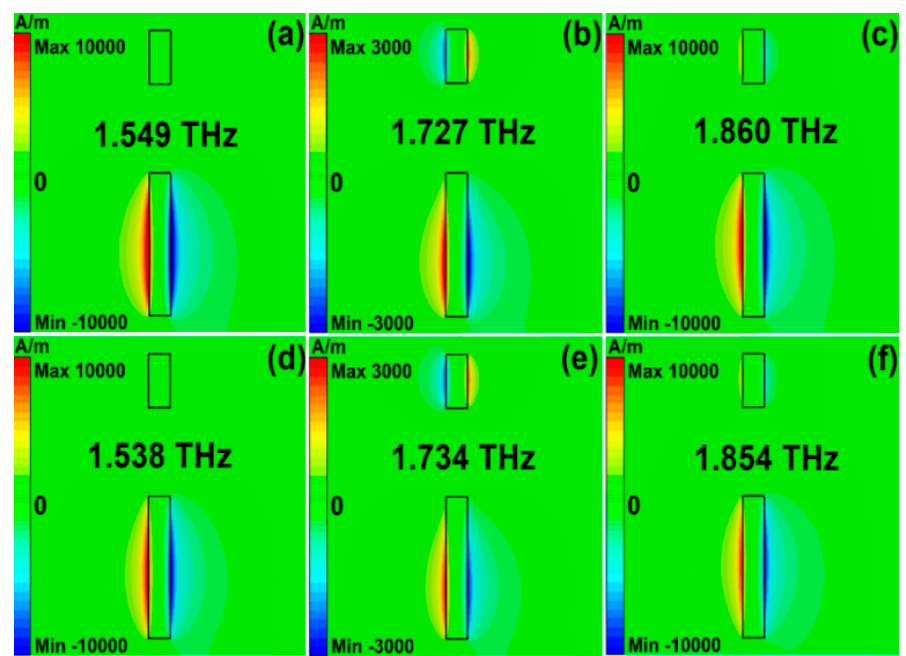
Figure 6. The magnetic fields for the asymmetrical graphene cut wire patters structures. ( a–c ) The simulation results for Model I. ( d–f ) The simulation results for the phonon scattering was taken into account. The polarization direction of incident light was along the y direction.